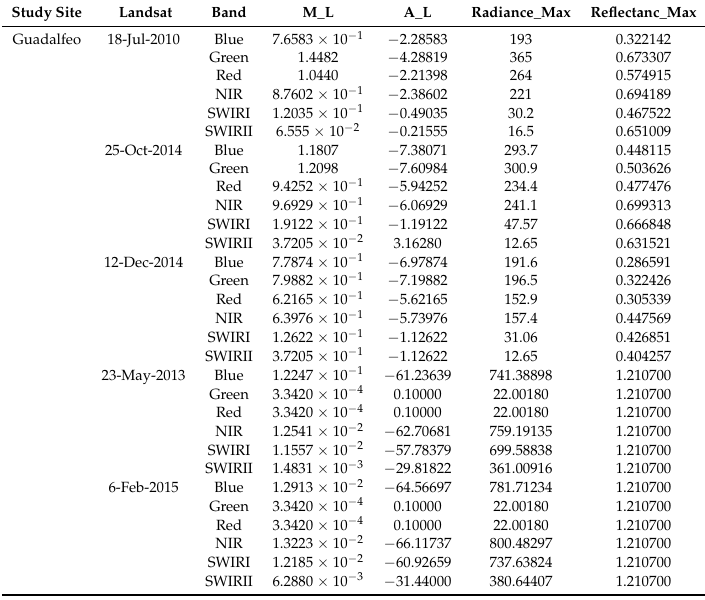
Table A2. Parameters from Landsat images used in statistic calculations to asses the